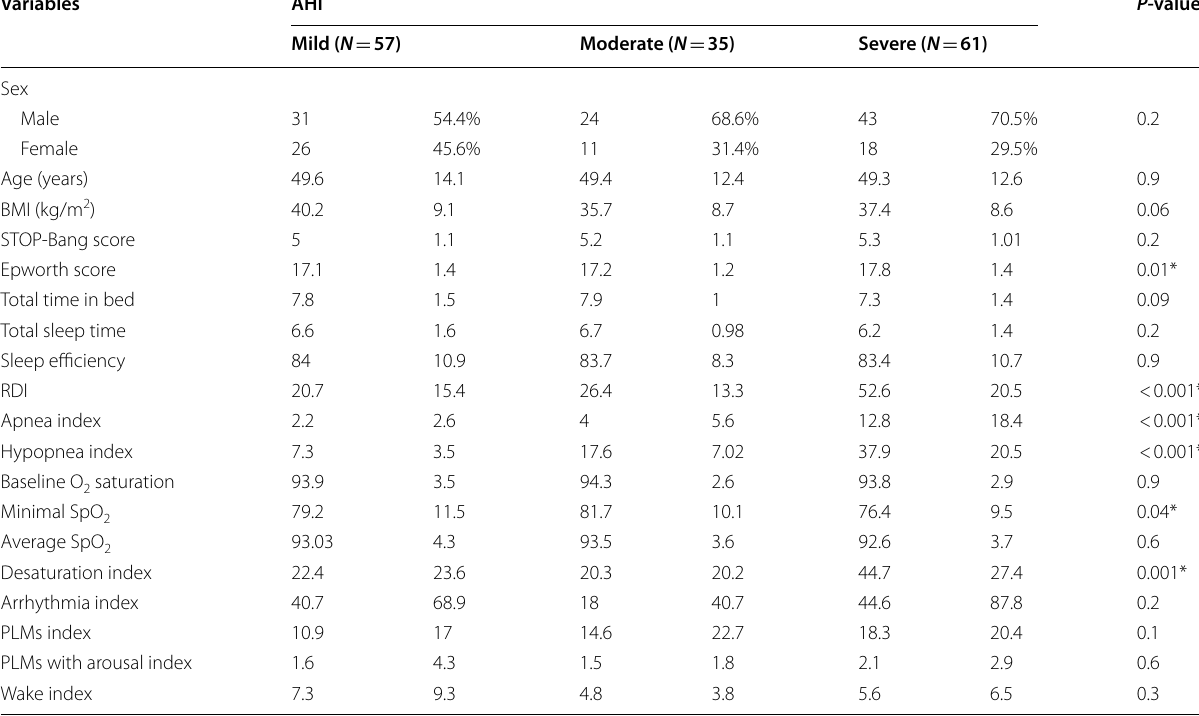
Table 3 Comparisons of study parameters in different AHI severity degrees Variables